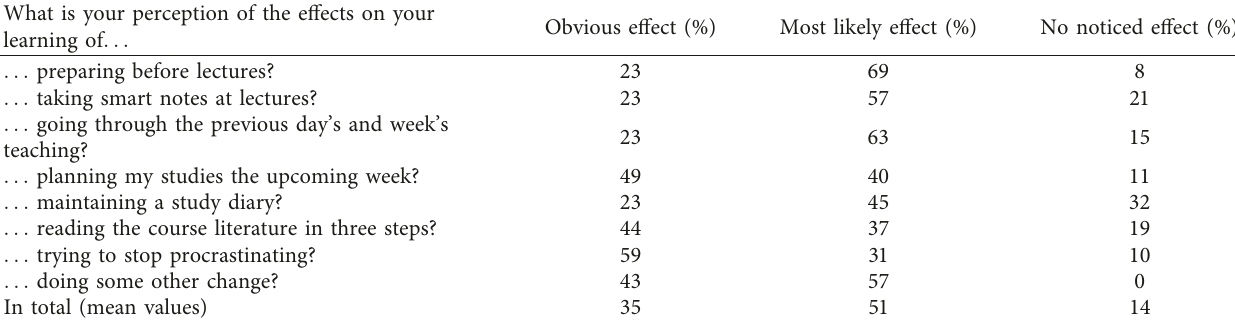
Table 5: Results from the postquestionnaire on the effects on the students’ learning. What is your perception of the effects on your learning of . ..